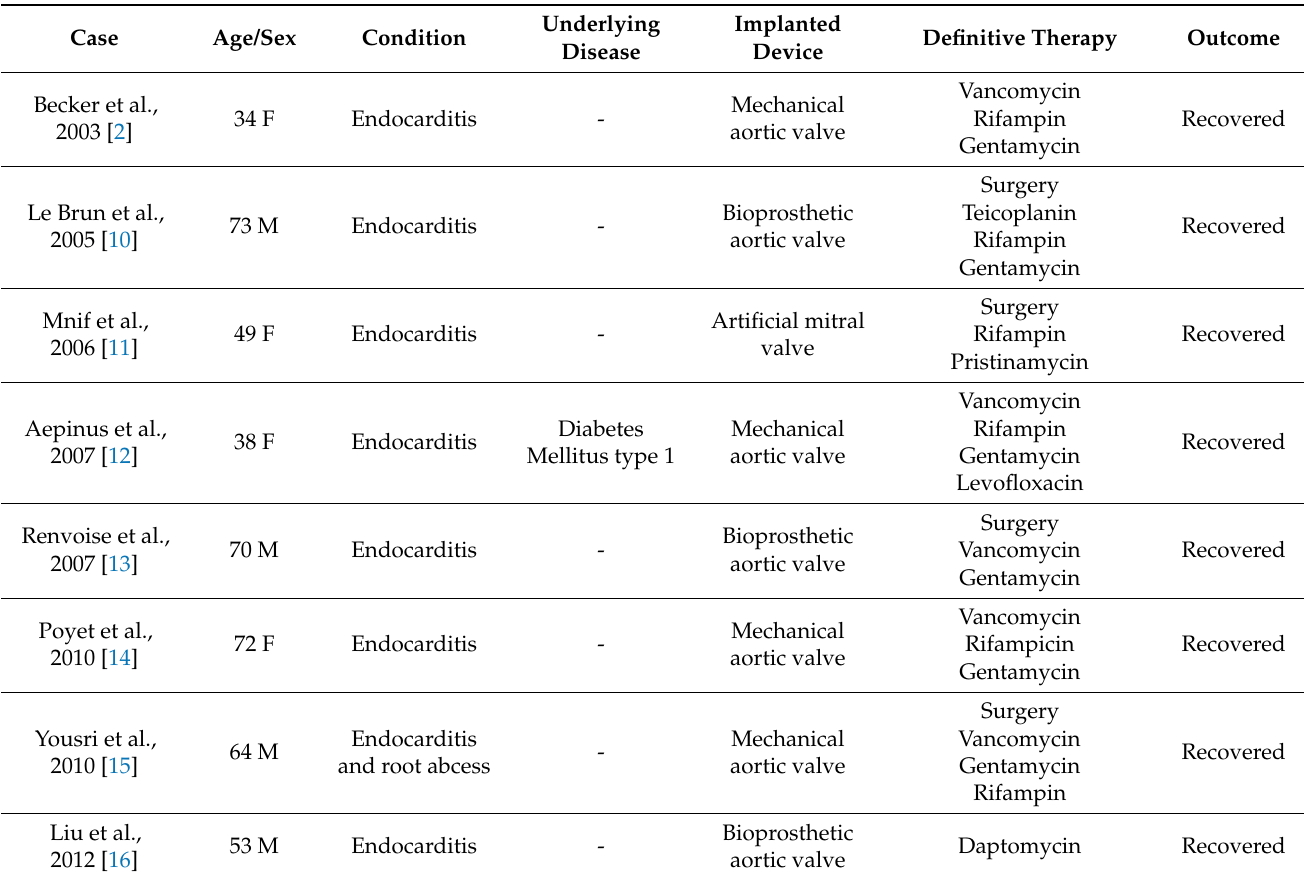
Table 3. Endocarditis cases.